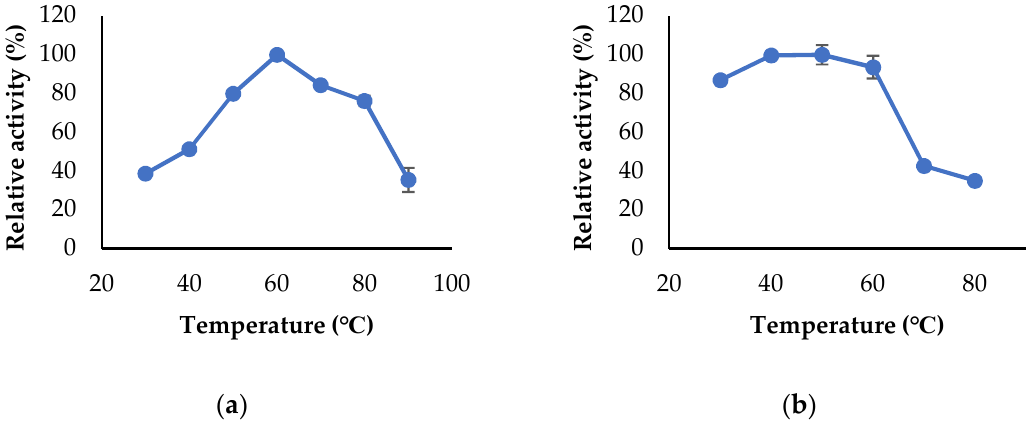
Figure 4. Optimum temperatures of Est2L ( a ) and Est4L ( b ). Enzyme activities were measured by a continuous method at each designated temperature.